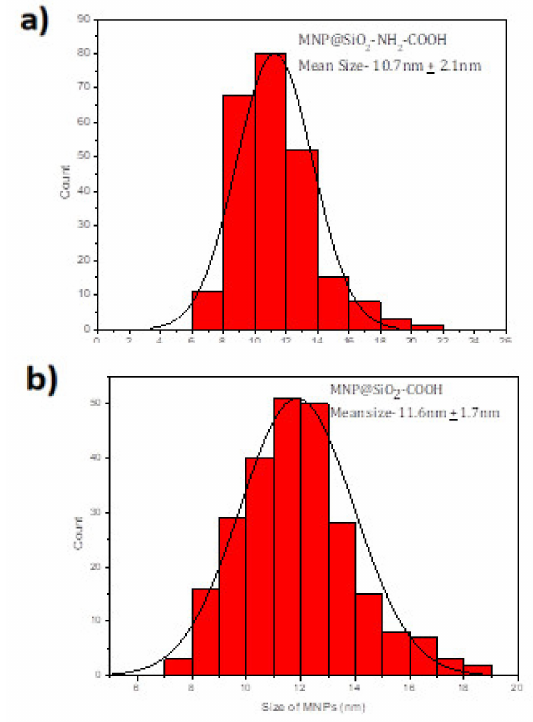
Figure 3. The average size of ( a ) Fe 3 O 4 @SiO 2 -NH 2 MNPs is 10.7 ± 2.1 nm and ( b ) Fe 3 O 4 @SiO 2 -NH 2 -COOH MNPs is 11.6 ± 1.7